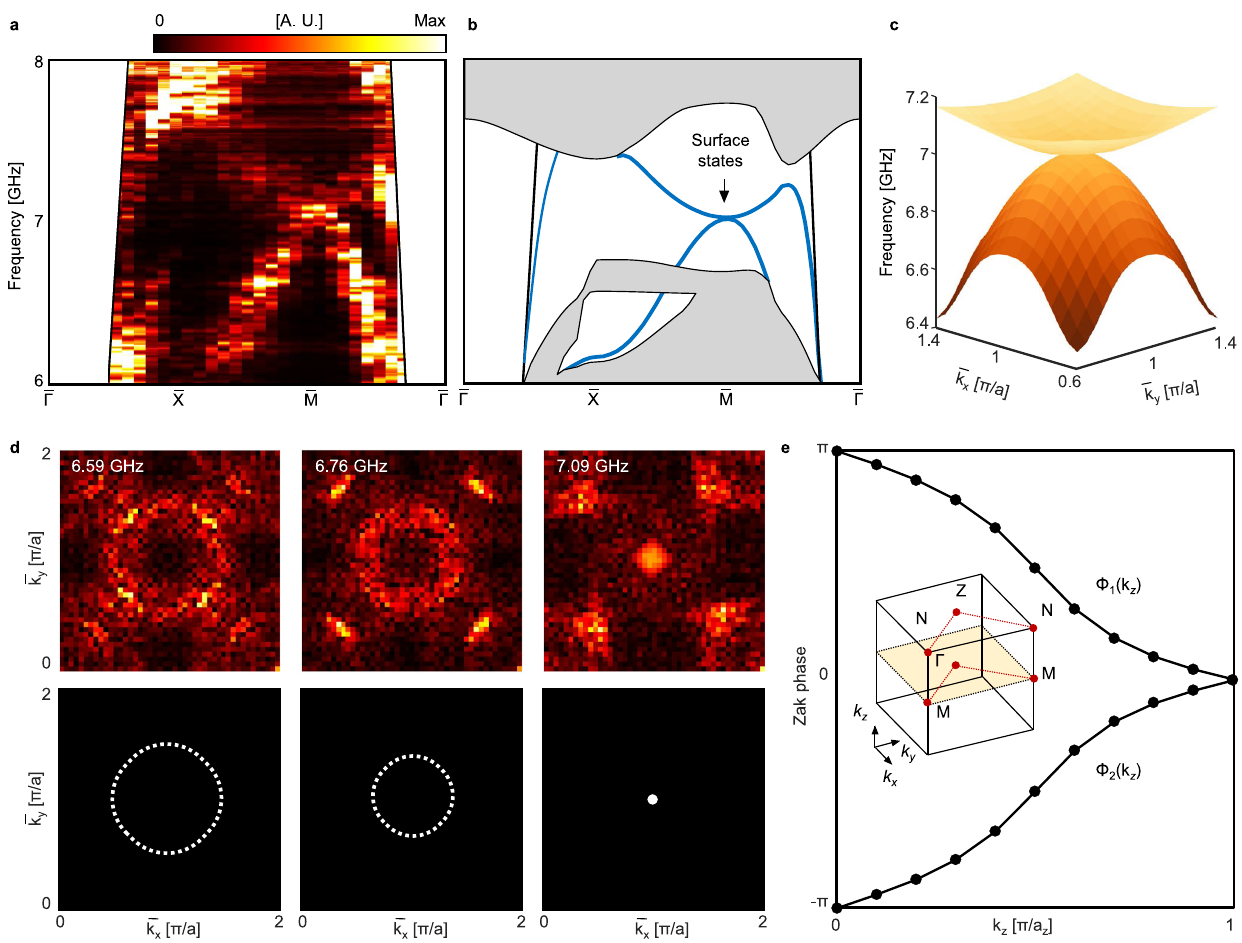
Fig. 3 Topological quadratic surface states on the (001) surface of the 3D PTI. a , b Measured ( a ) and simulated ( b ) surface dispersions. Gray areas represent the projected bulk bands and blue curves denote surface states localized at the top surface. Black lines indicate the light cone. c Simulated surface dispersion in the (001) surface BZ. d Measured (top) and simulated (bottom) isofrequency contours of the surface states at 6.59, 6.76, and 7.09 GHz. e Spectral fl ow of the Zak phases. Inset shows the 3D BZ with a family of C 4 -invariant loops, along which the Zak phases are calculated. The Zak phase diagram proves the nontrivial ℤ 2 topological invariant, v 0 =